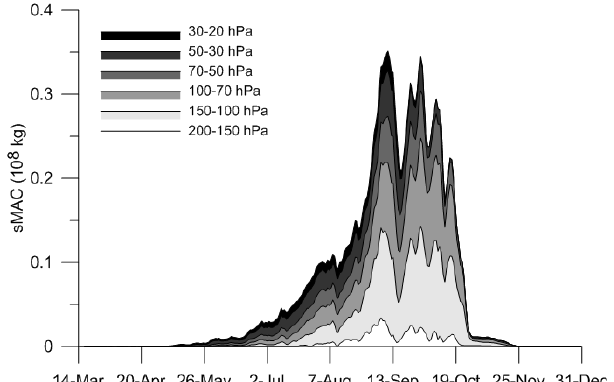
Fig. 3. Contribution from different atmospheric layers (as indicated in the legend) to the sunlit mass of activated chlorine for the year 2000. Largest contributions come from pressures between 150–